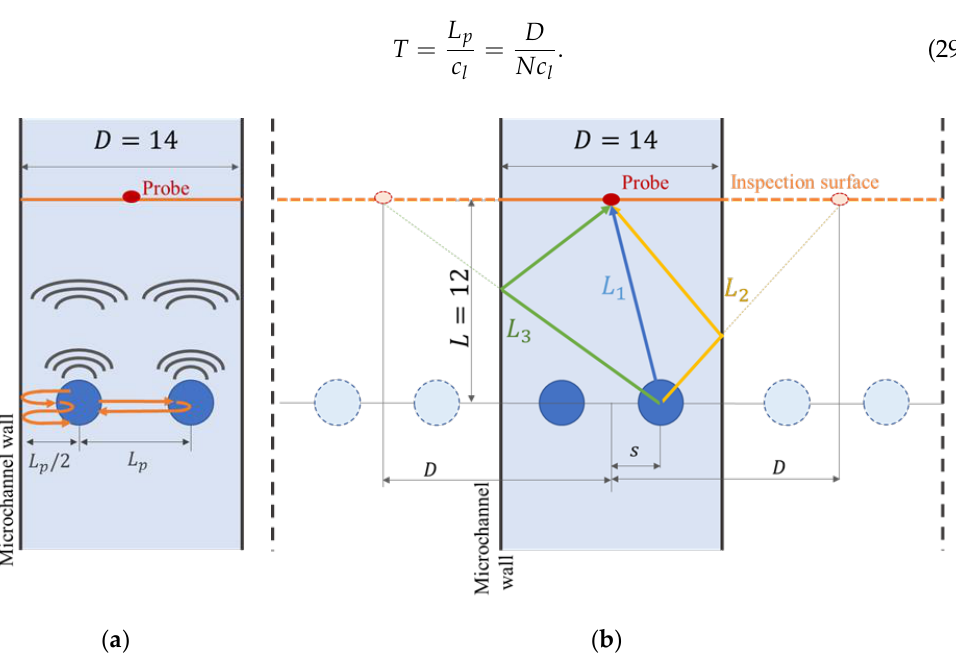
Figure 12. Path of the pressure wave from the bubble in the case of multiple bubbles. The path of the pressure wave is the same as the length shown by the dashed line. ( a ) Path of the pressure wave between the bubbles; ( b ) Path of the pressure wave to the inspection surface.